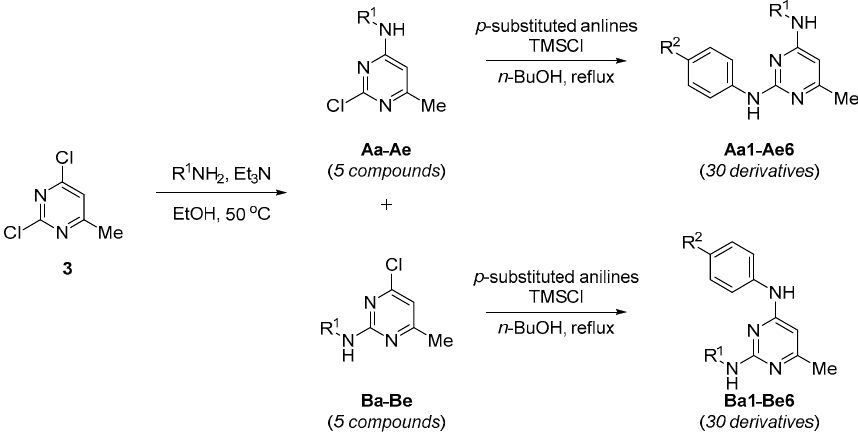
Scheme 1. Synthetic procedure of pyrimidine library. Table 1. Chemical structures of synthesized